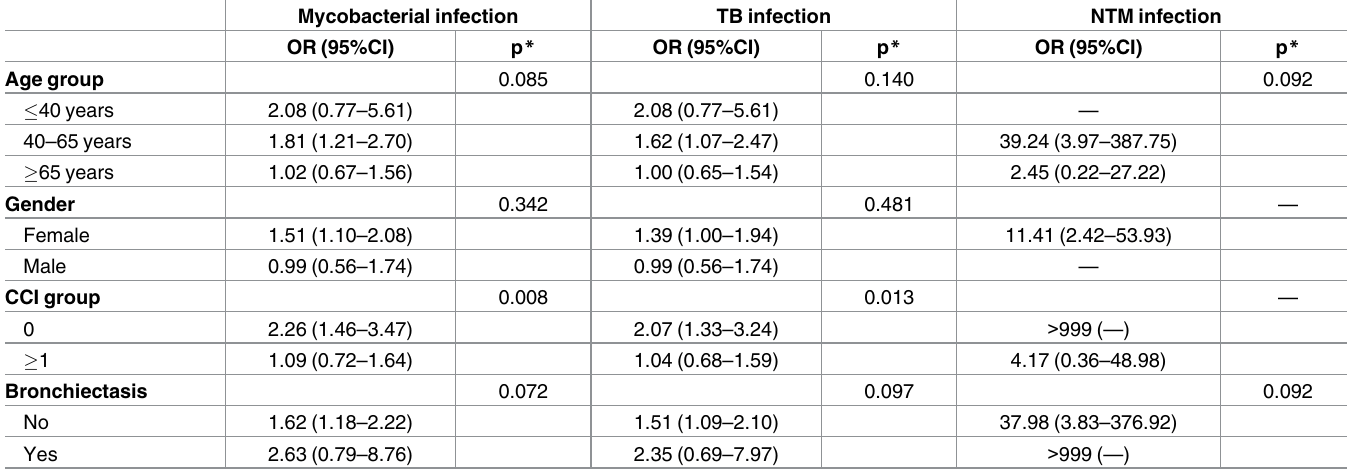
Table 4 details the medication history in subjects with NTM infection. As expected, all of the seven subjects with NTM infection underwent the clarithromycin-containing regimen, except for one subject (subject 4) who might be intolerant of clarithromycin and was treated mainly with moxifloxacin and doxycycline (Table 4). The treatment duration was quite long in Table 3. Stratified analysesfor the association between mycobacterial infection and risk of Sjogren’s